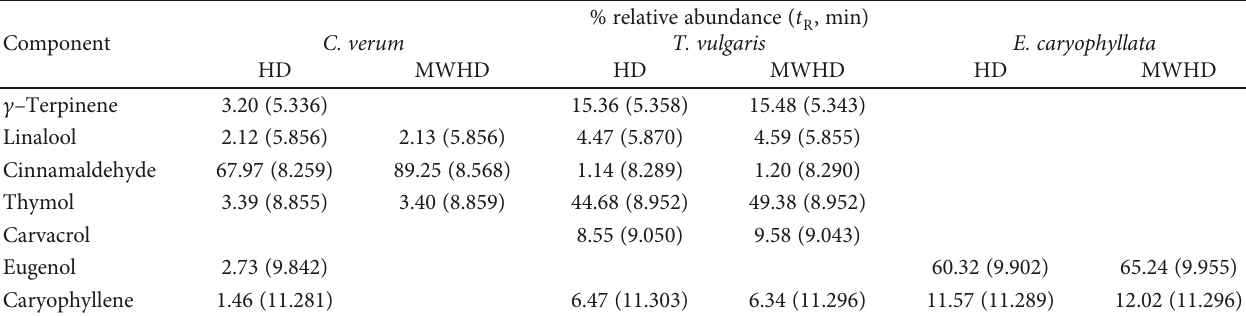
Table 2: Major components detected in EO obtained by HD and MWHD.